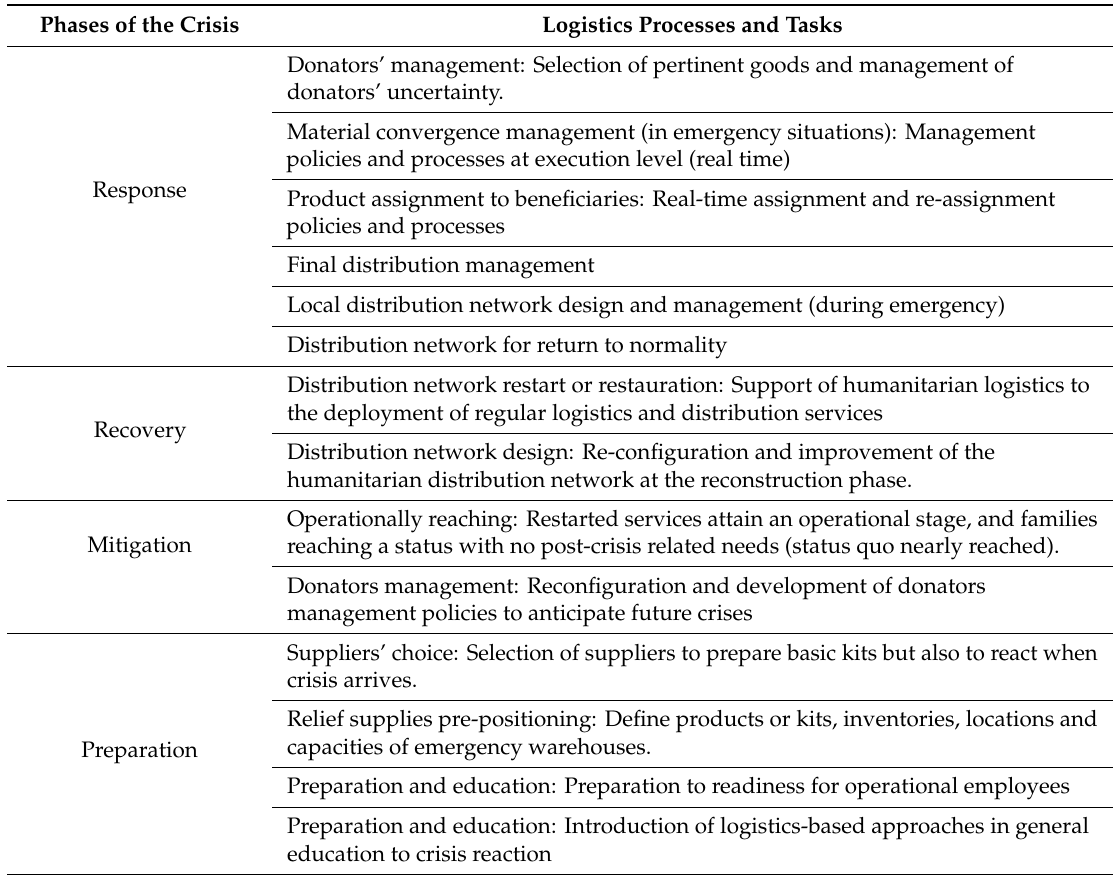
Table 3. The main logistics elements of the maturity model to respond to crisis (obtained inductively with evidence from the three selected cases; elaboration: